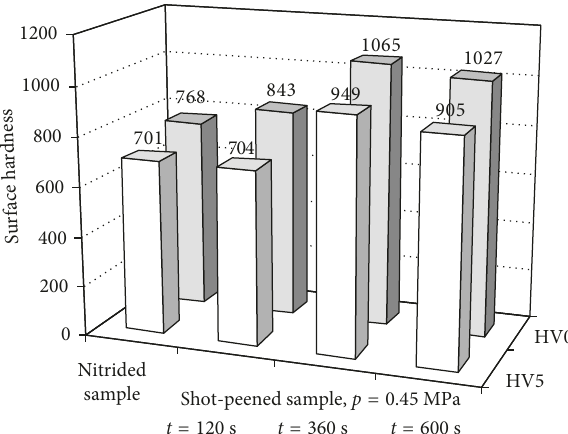
Figure 7: The surface hardness after nitriding process (nitrided sample) and after combined process of shot peening and nitriding.